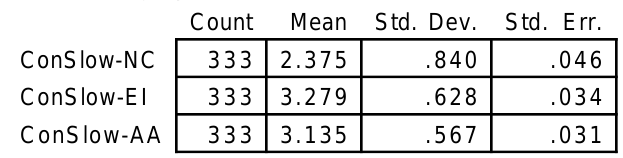
Means Table for ConSlow Effect: Category for ConSlow